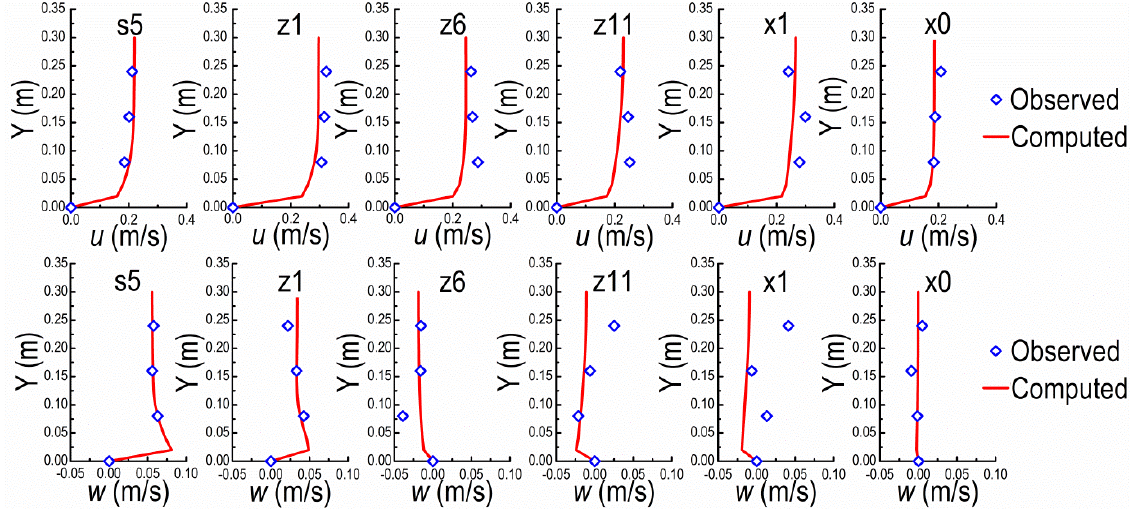
Figure 3. Distributions of u , w along Y at verification cross-sections on the central axis of flume.